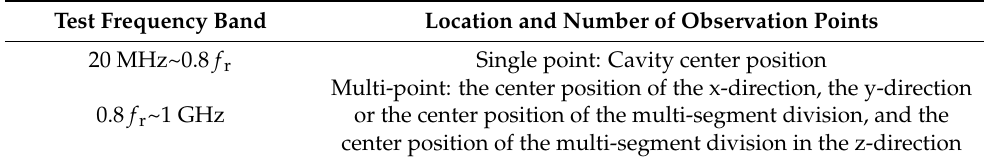
Figure 15. Shielding test arrangement. Table 2. Location and number of observation points.